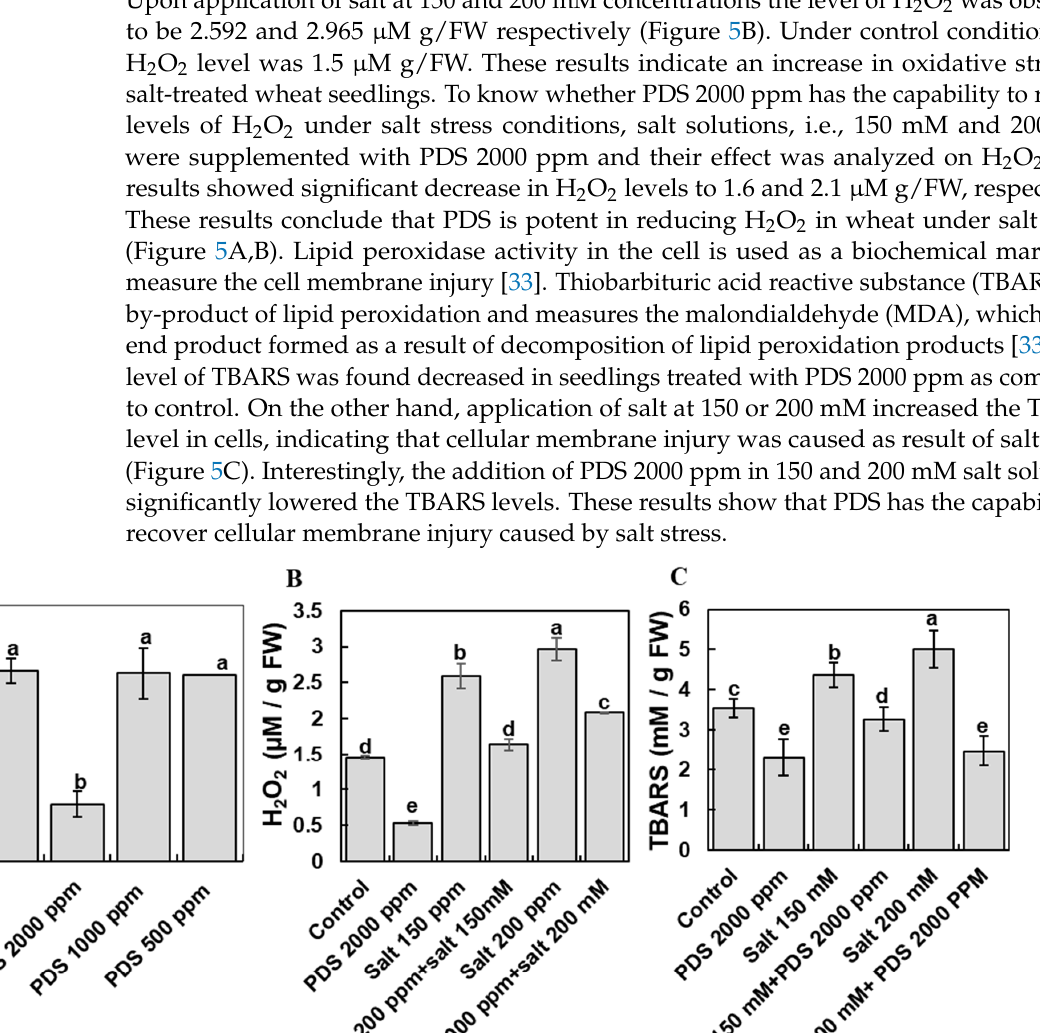
patterns of SOS4 . ( C ) HKT2 . ( D ) P3CS . ( E ) BADH . The x -axis shows the type of treatment and y -axis